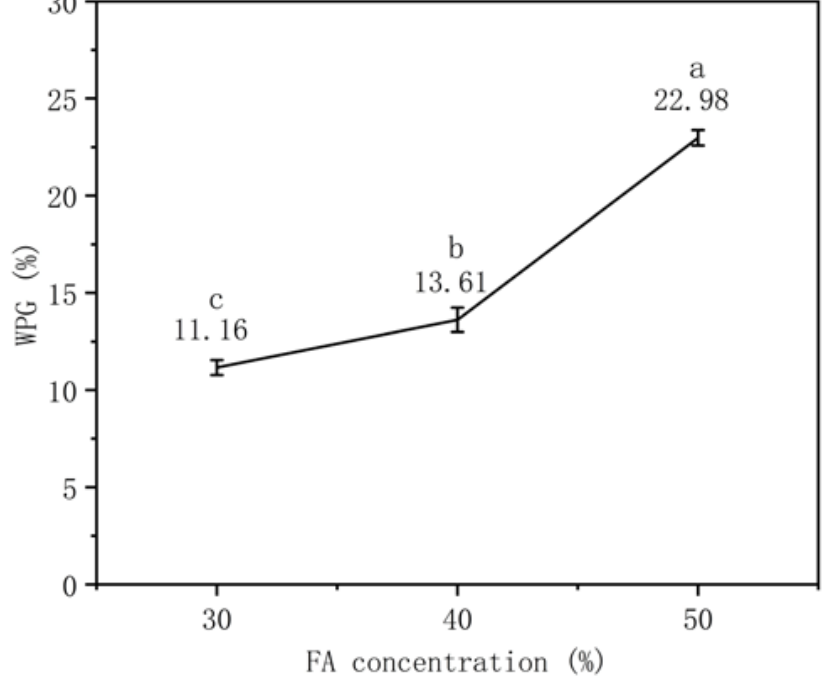
Figure 2. WPG (numbers) and their significant differences (letters) of specimens at different concen- trations (30, 40 and 50%).